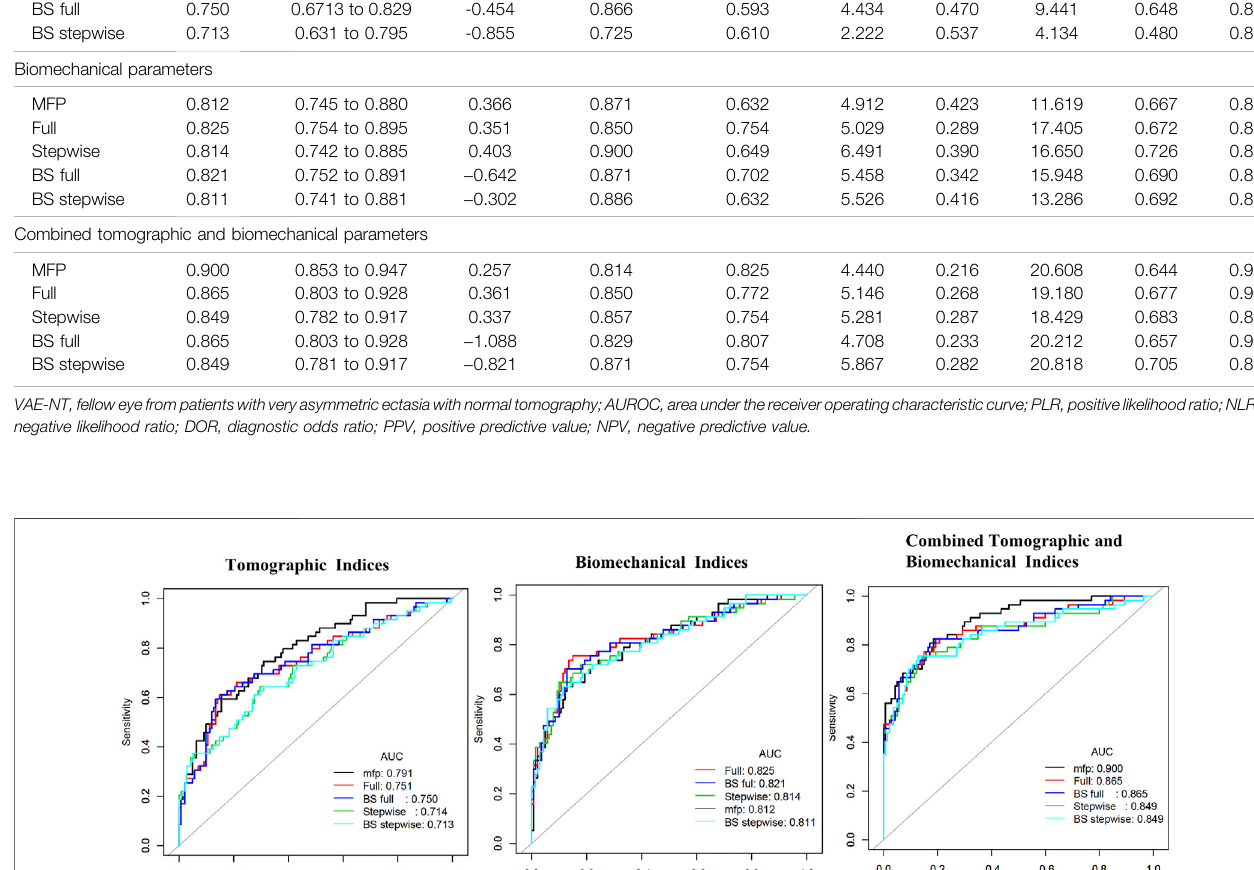
Frontiers in Bioengineering and Biotechnology |